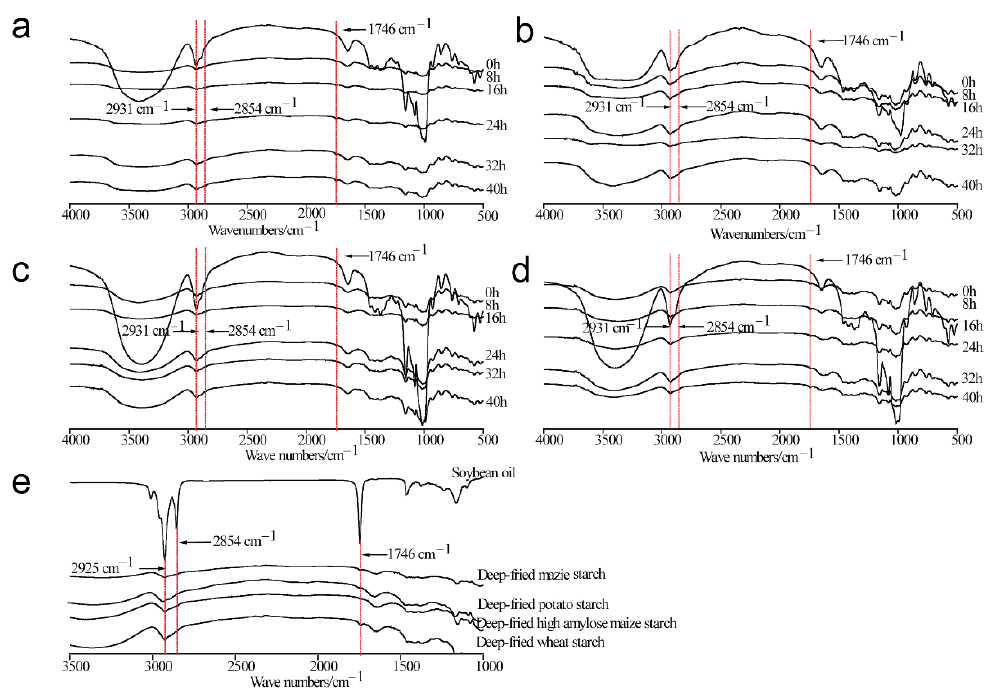
Figure 2. Fourier transform infrared (FTIR) spectra of native maize starch, potato starch, high-amylose maize starch, and wheat starch (0 h), as well as those during the deep-frying process (8 h, 16 h, 24 h, 32 h, 40 h). ( a ) Maize starch; ( b ) Potato starch; ( c ) High-amylose maize starch; ( d ) Wheat starch; ( e ) Soybean oil and deep-fried starch samples at 8 h.